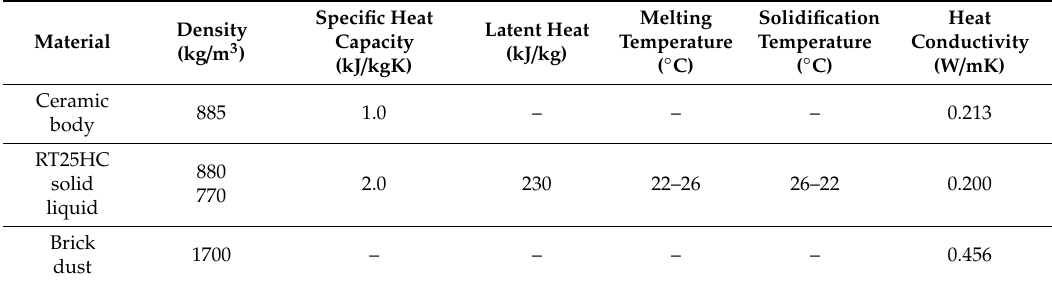
Table 1. Selected parameters characterizing individual elements of the ceramic composite.